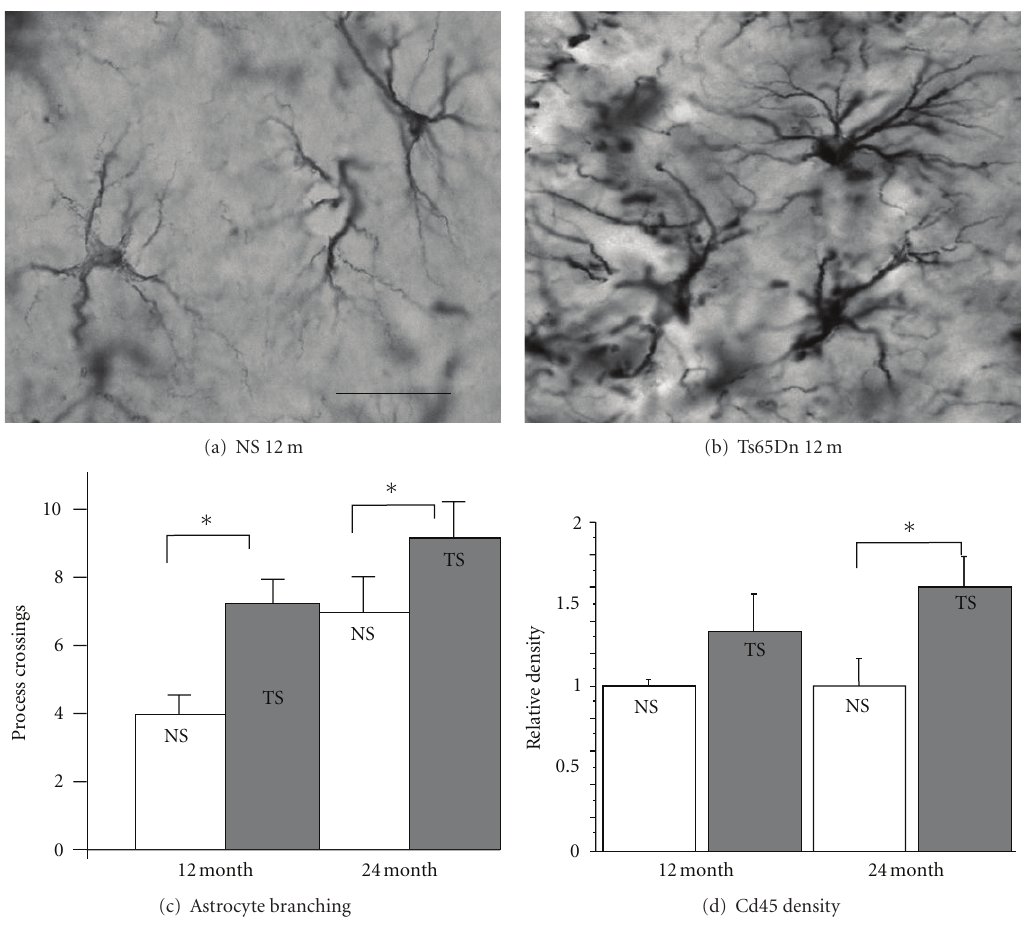
Figure 2: Gliosis in hippocampus of Ts65Dn mice. Brain tissue sections from Ts65Dn mice and age-matched normosomic littermates, showing typical hippocampal morphology of astrocytes, using the glial marker GFAP (a) and (b). The sections were from 12-month-old normosomic (NS, a) or Ts65Dn (TS, b) mice. Note increased number of astrocytes in TS mice, as well as elevated expression of GFAP and an activated morphology, with more branching and thicker branches in the TS compared to NS mouse. (c) Astrocyte branching measurements (GFAP labeling) in the hippocampus reveal increased branching in TS mice compared to NS age-matched controls, a sign of activation following inflammatory or other pathological processes. Astrocytosis is increased with aging in the TS mice to a greater extent than in NS mice. (d) Density of a marker for microglial cells, Cd45, is also increased with age in Ts65Dn (TS) but not in age-matched normosomic (NS) mice, indicating ongoing microglial activation in this brain region. Inset in (b) represent 100 microns. Data were not published previously